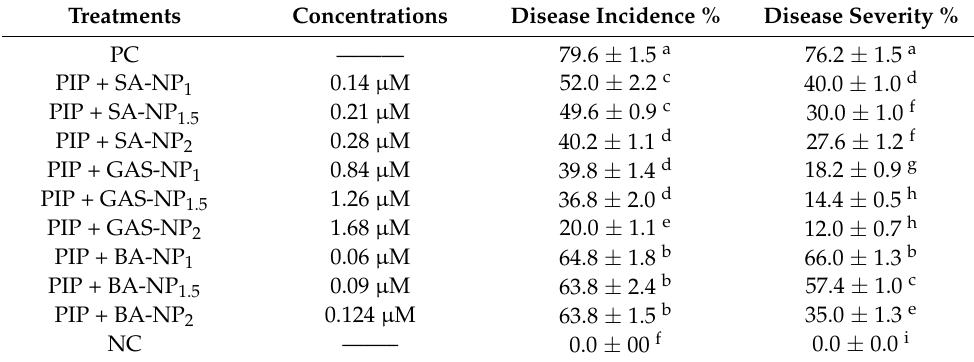
Table 2. Effect of SA-NPs, GAS-NPs, and BA-NPs treatments on